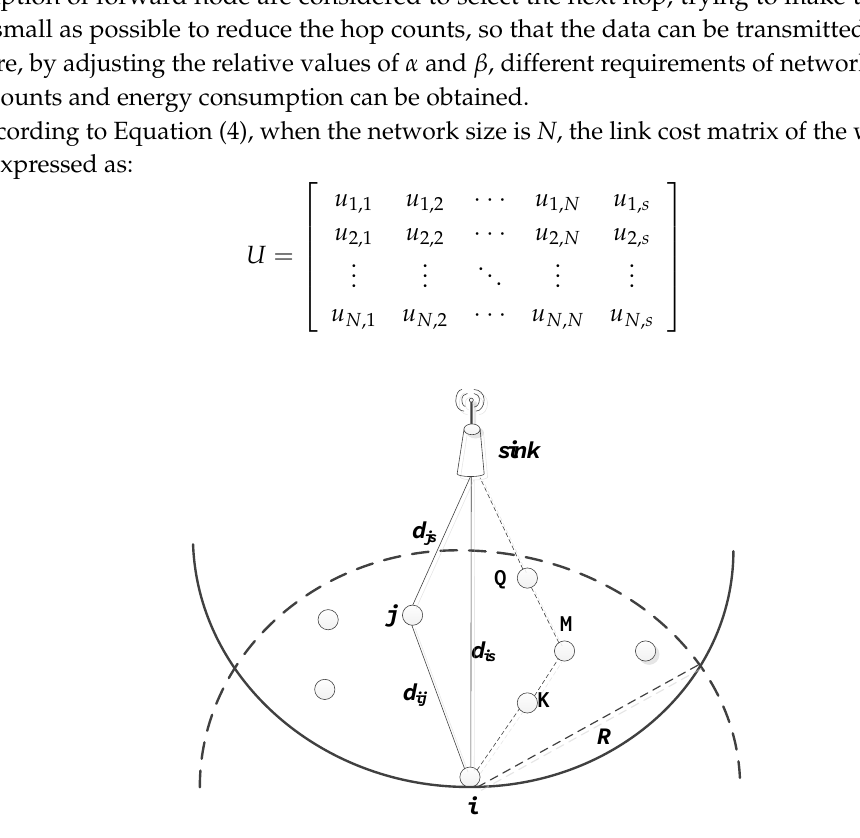
Figure 1. Spatial positional relationship between nodes.